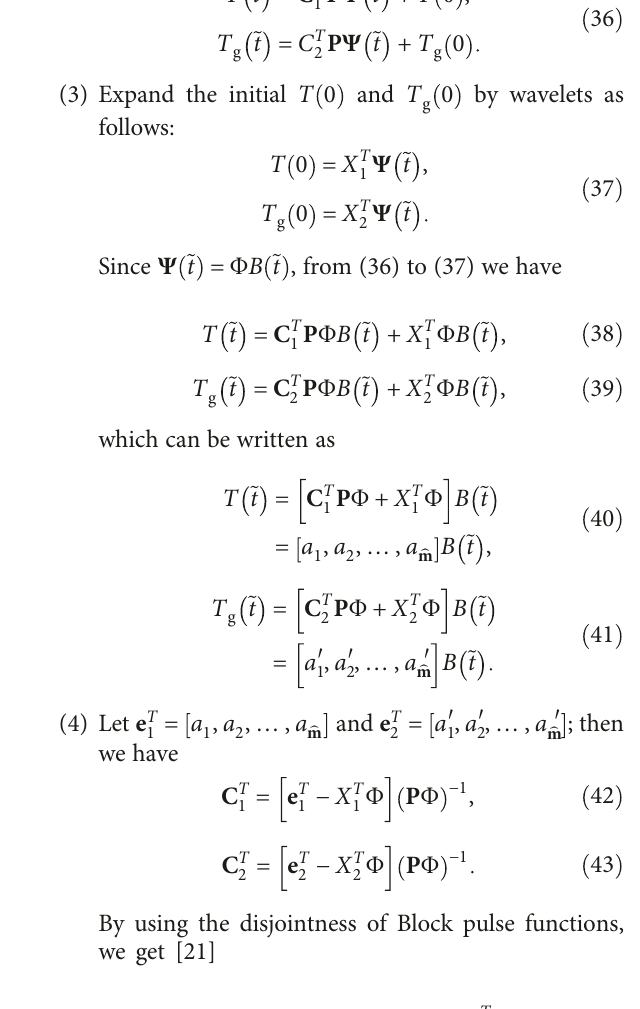
Figure 2: Integration of e t .